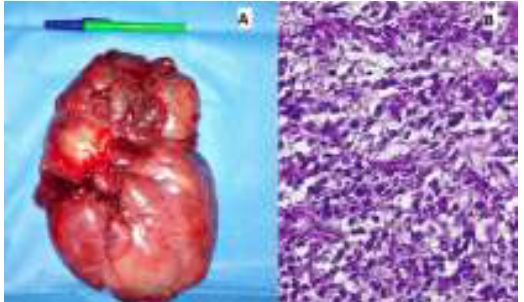
Figure 3: (A) Gross pathologic finding of the tumor (specimen): an encapsulated massmeasuring17 cm × 16 cm × 10 cm after it was removed and weighed 3500 g, tumor revealed a light brown color, an internal lobulated multicystic structure (B): Histological findings of the tumor. The tumor was composed of a lymphocyte associated area and was diagnosed as a WHO type AB thymoma without capsular invasion (Masaoka stage I